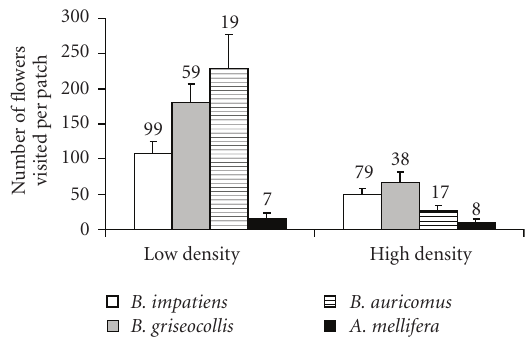
Figure 2: The impact of bee species and plant density on the number of flowers visited per patch during one foraging